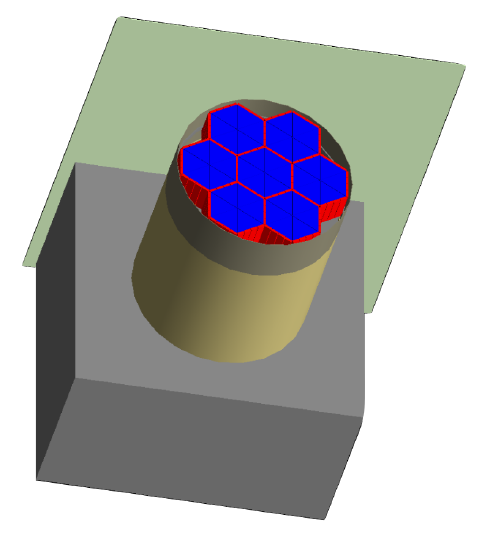
Figure 2. The SPHiNX satellite as implemented in Geant4. The figure shows the geometry of the solar panel (green), InnoSat platform (grey), shielding (the upper brown cylinder), support structure (the bottom yellow cylinder) and sensitive scintillators (blue and red components inside the shielding). For clarity, the CFRP window covering the instrument aperture is not